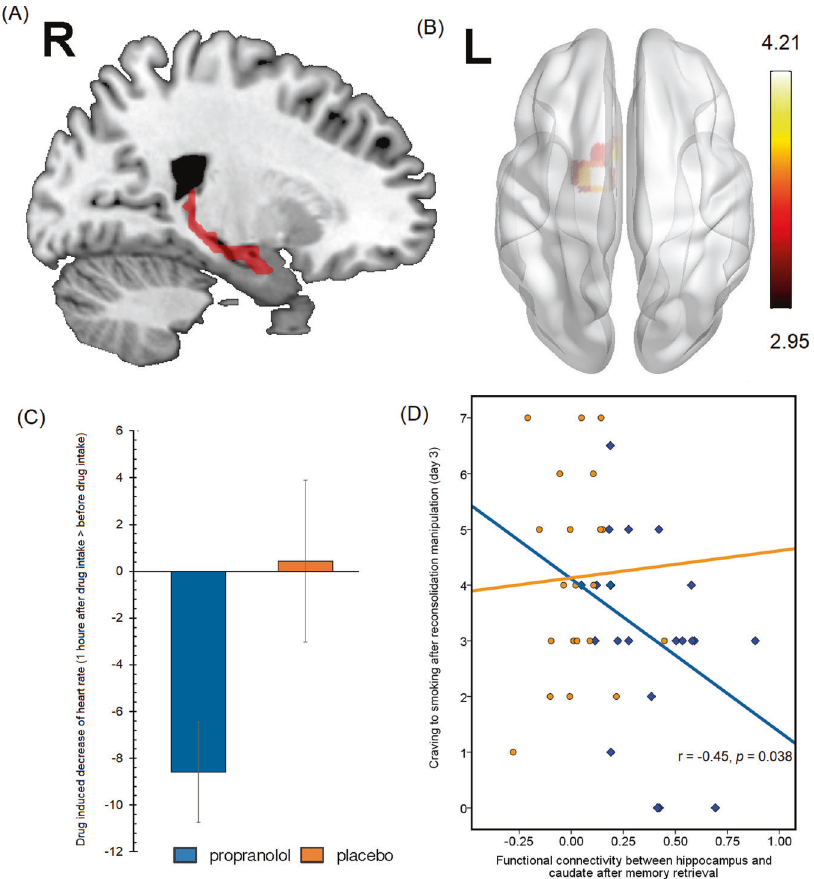
Fig. 3 Increase in functional connectivity between the hippocampus and striatum in the propranolol group during the reconsolidation process. A , B The hippocampus as the region of interest and brain regions that showed an increase in connectivity with the hippocampus in the propranolol group during the second resting-state fMRI scan. C Propranolol administration signi fi cantly decreased heart rate. D Functional connectivity between the hippocampus and striatum negatively correlated with craving scores on day 3 in the propranolol group. No signi fi cant correlation was detected in the placebo